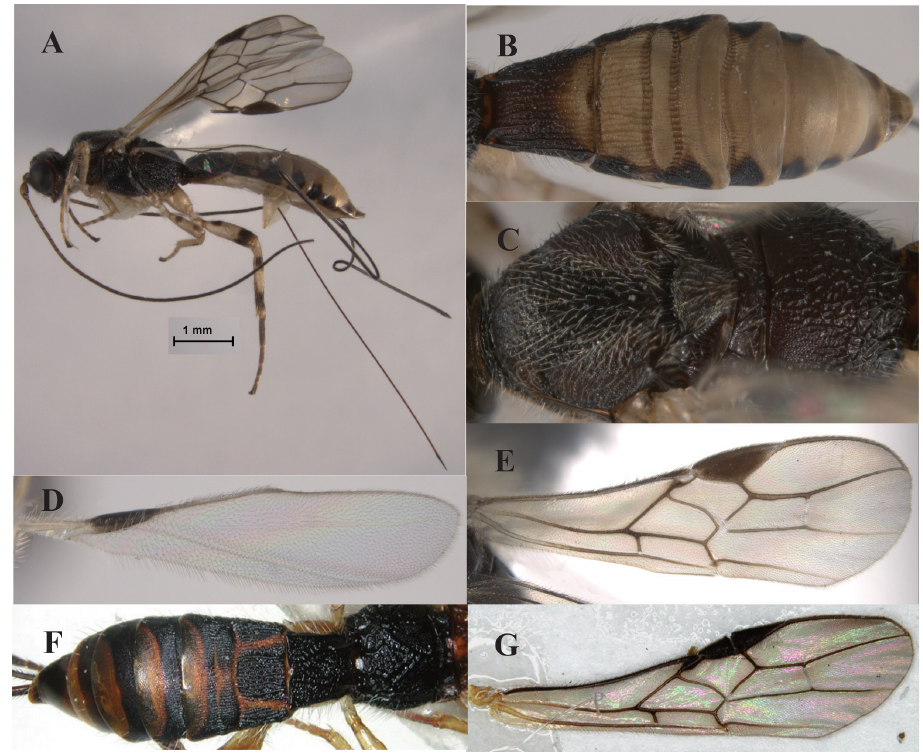
Figure 6. Ondigus cuixmalensis sp. n. (holotype): A habitus, lateral view B metasoma, dorsal view C mes- osoma, dorsal view D hind wing, lateral view (male, paratype) e fore wing, lateral view. Ondigus bicolor Braet, Barbalho & van Achterberg: F propodeum and metasoma, dorsal view G fore